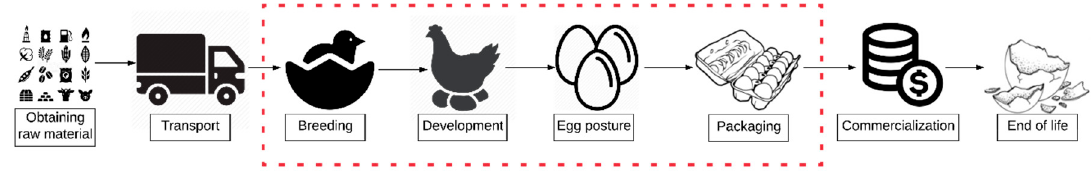
Figure 3. Limits of the system product in the valuation of environmental impacts by LCA.